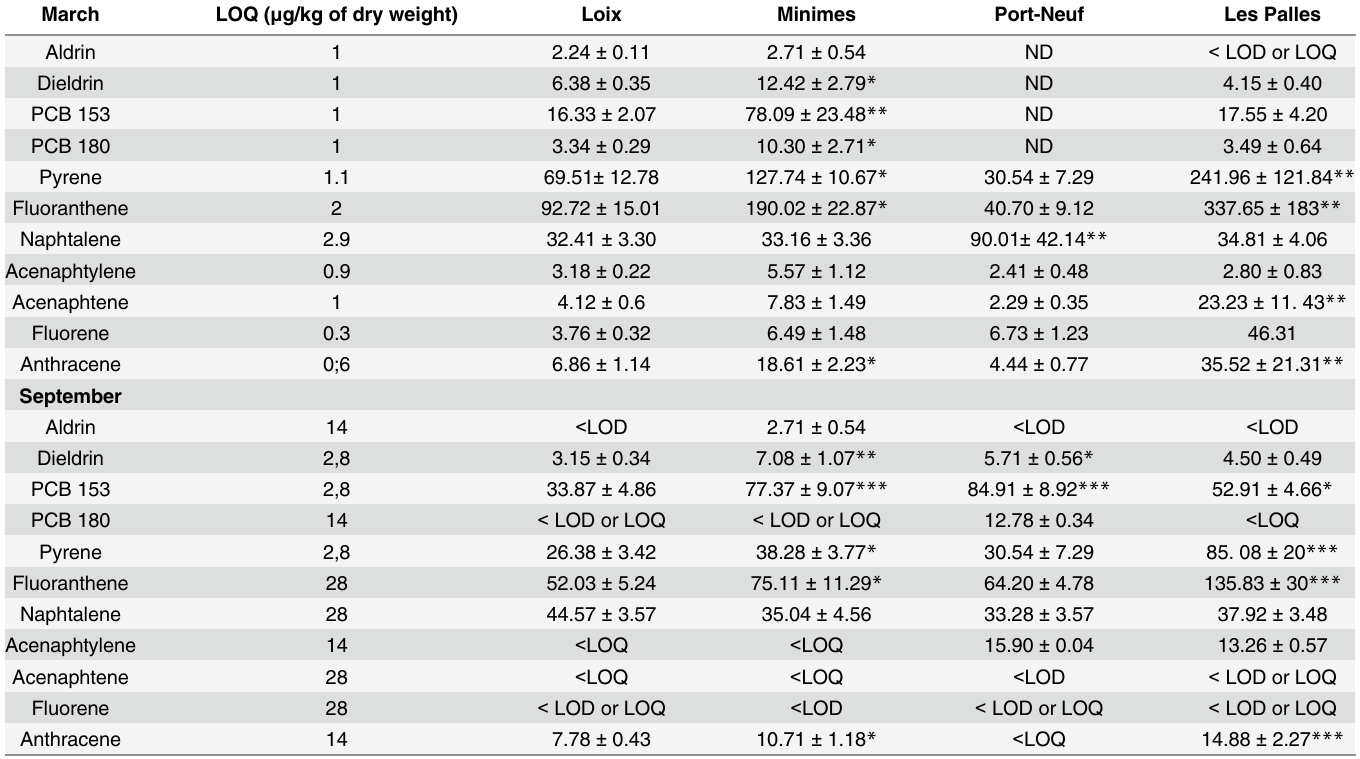
Table 3. Organic contaminants concentrations ( μ g/kg of dry weight) in the digestive glands of Mimachlamys varia (5 < n < 10 per sites) from the four sampling areas (Loix-en-Ré, Minimes, Port-Neuf, Les Palles) in March 2014 and in September